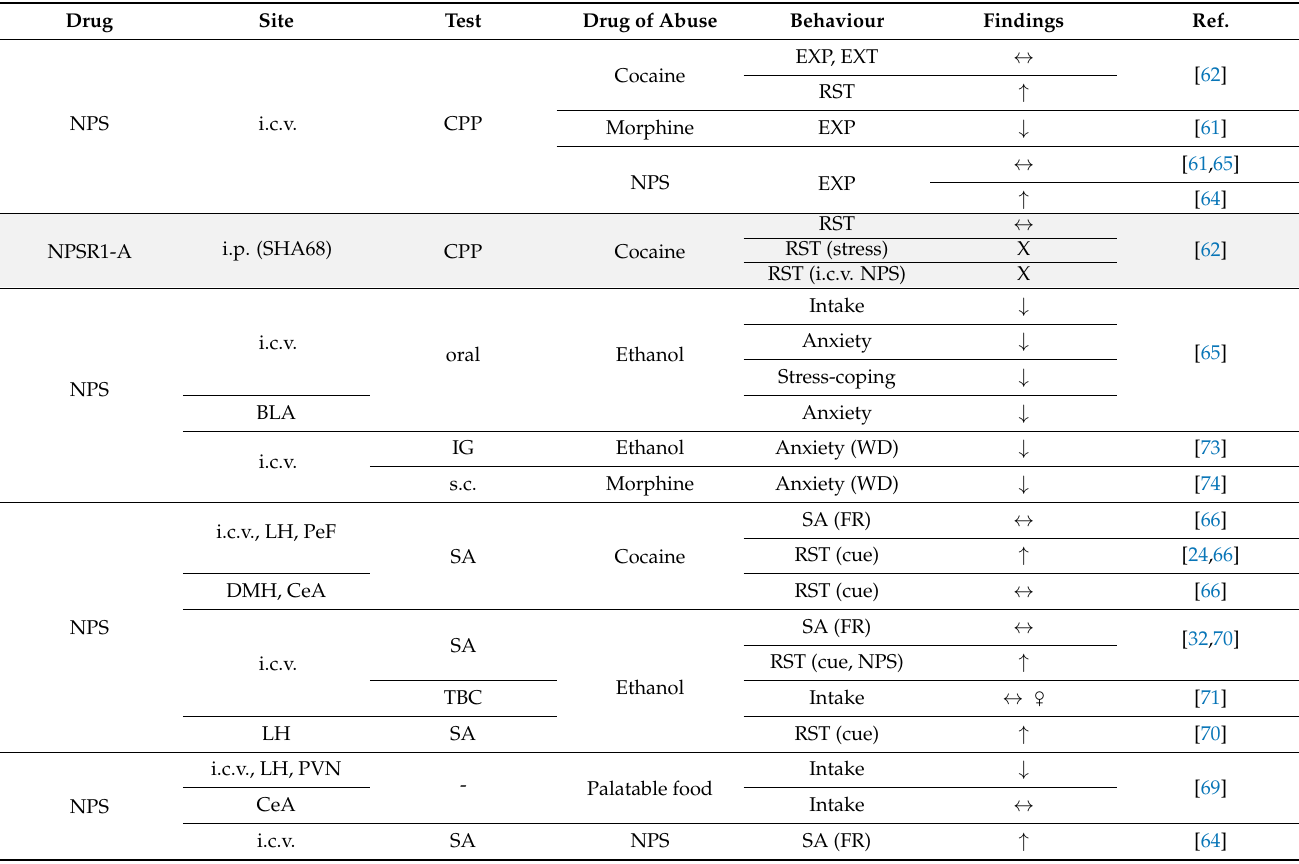
Table 3. Summary of the preclinical studies showing the role of the NPS/NPSR1 system in addiction-like behaviours. Drug Site Test Drug of Abuse Behaviour Findings